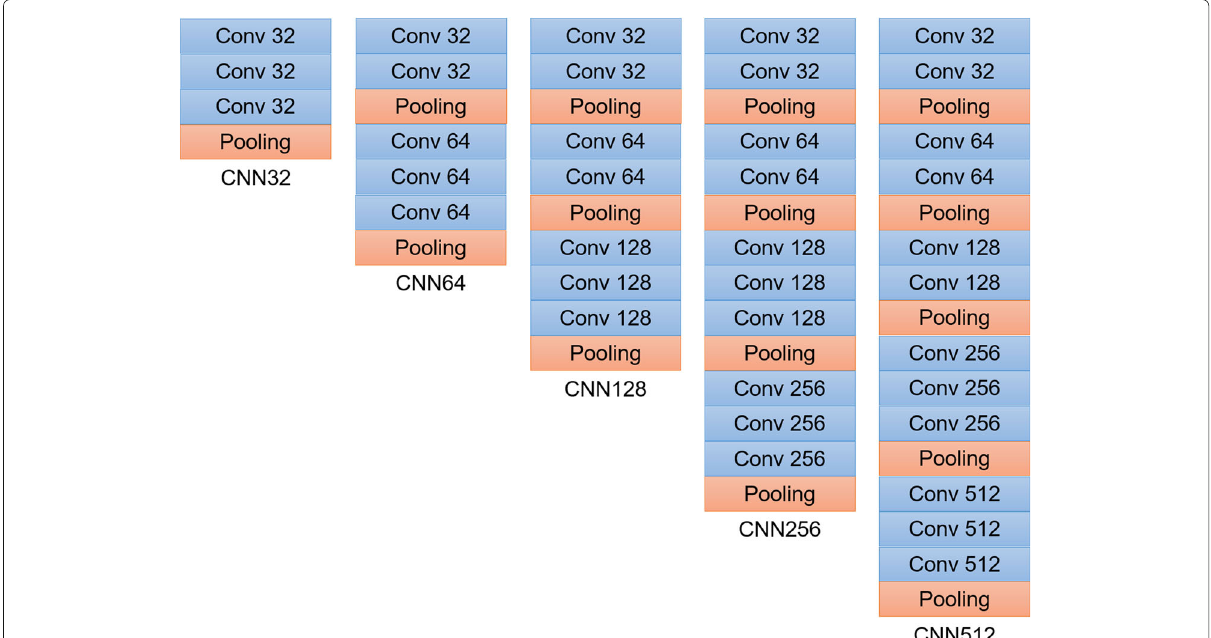
Fig. 1 The architecture of CNN models of different number of convolutional